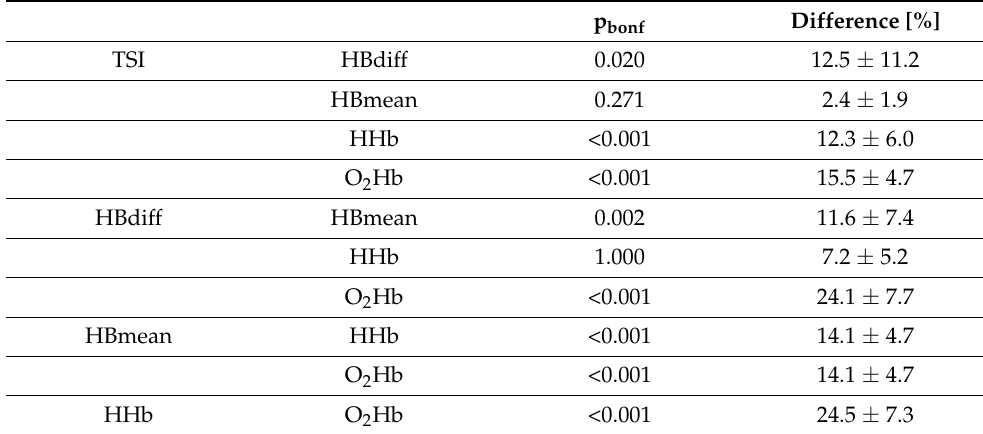
Table 1. Overview of Bonferroni corrected post-hoc results (p bonf ) for the main effect approaches and the percentage difference (± standard deviation) of the comparisons.